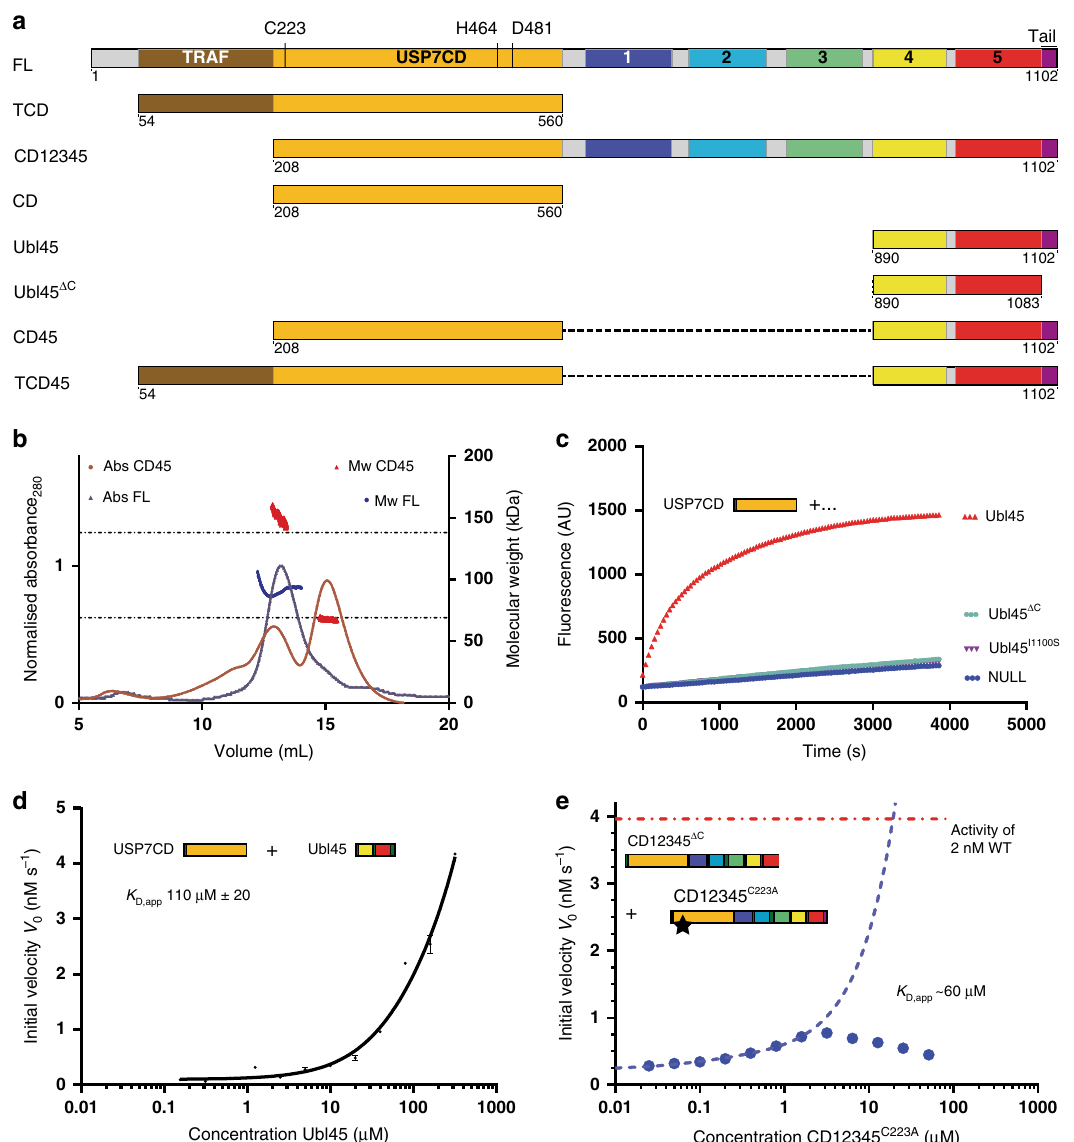
Fig. 1 USP7 activation by the C-terminal tail happens in cis . a Schematic domain representation of USP7 and constructs used in this study. Active site residues and domain names are indicated: TRAF TRAF domain, CD Catalytic domain, 1 – 5 Ubl domains 1 through 5, tail. The activating C-terminal peptide (res. 1083 – 1102), marked in purple. The graphical representation of the constructs is used in other fi gures. b Analysis of USP7 constructs on SEC-MALLS shows monomer/dimer equilibrium. CD45 (100 µ L of 45 µ M) or FL (80 µ L of 20 µ M) were loaded on a Superdex 200 gel fi ltration column. Absorbance at 280 nm (dark red: CD45; dark blue: FL) was monitored and eluted peaks were analysed for molecular weight (red: CD45; blue: FL) by in-line MALLS. For CD45 the molecular weights of the monomer (69 kDa) and dimer (138 kDa) are indicated with the dotted line. c Activation of USP7CD by Ubl45 requires the very C-terminal tail. CD (20 nM) was mixed with Ubl45 variants as indicated and tested for DUB activity using UbRho. d USP7CD (20 nM) was incubated with a titration range of Ubl45, and tested in a deubiquitination assay as in 1c. These initial velocities were plotted against the concentration to yield an apparent K D . Each data point is the mean ± SD of n = 2 measurements. e CD12345 Δ C (20 nM) has similar activity to CD and can be activated by the tail: when titrating in CD12345 C223A , which has no activity, the tail will activate the tailless construct upon dimerization. The activity readout shows that this dimerization-dependent activation of USP7 happens at micromolar concentrations in line with af fi nity of 1d. Binding of ubiquitin substrate to CD12345 C223A causes an inhibitory effect above 2 µ M, therefore only lower concentrations were used to extrapolate a K D,app (blue dashes). The red dotted lines indicate the activity of WT CD12345 for